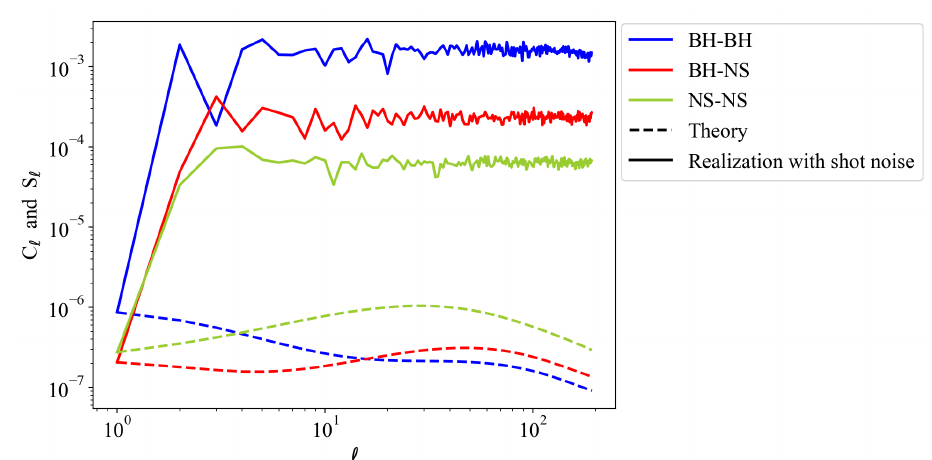
Figure A3. Power spectrum of the SGWB anisotropies at 65 Hz, measured by ET during an observa- tion time of T = 1 yr for BH-BH (blue), BH-NS (red) and NS-NS (green). The dashed curves are the theoretical auto-correlation power spectra shown in Figure 3. The solid curves are the power spectra of specific realizations of the SGWB that contain also the intrinsic shot noise contribution, a flat offset that outreaches the intrinsic correlation by orders of